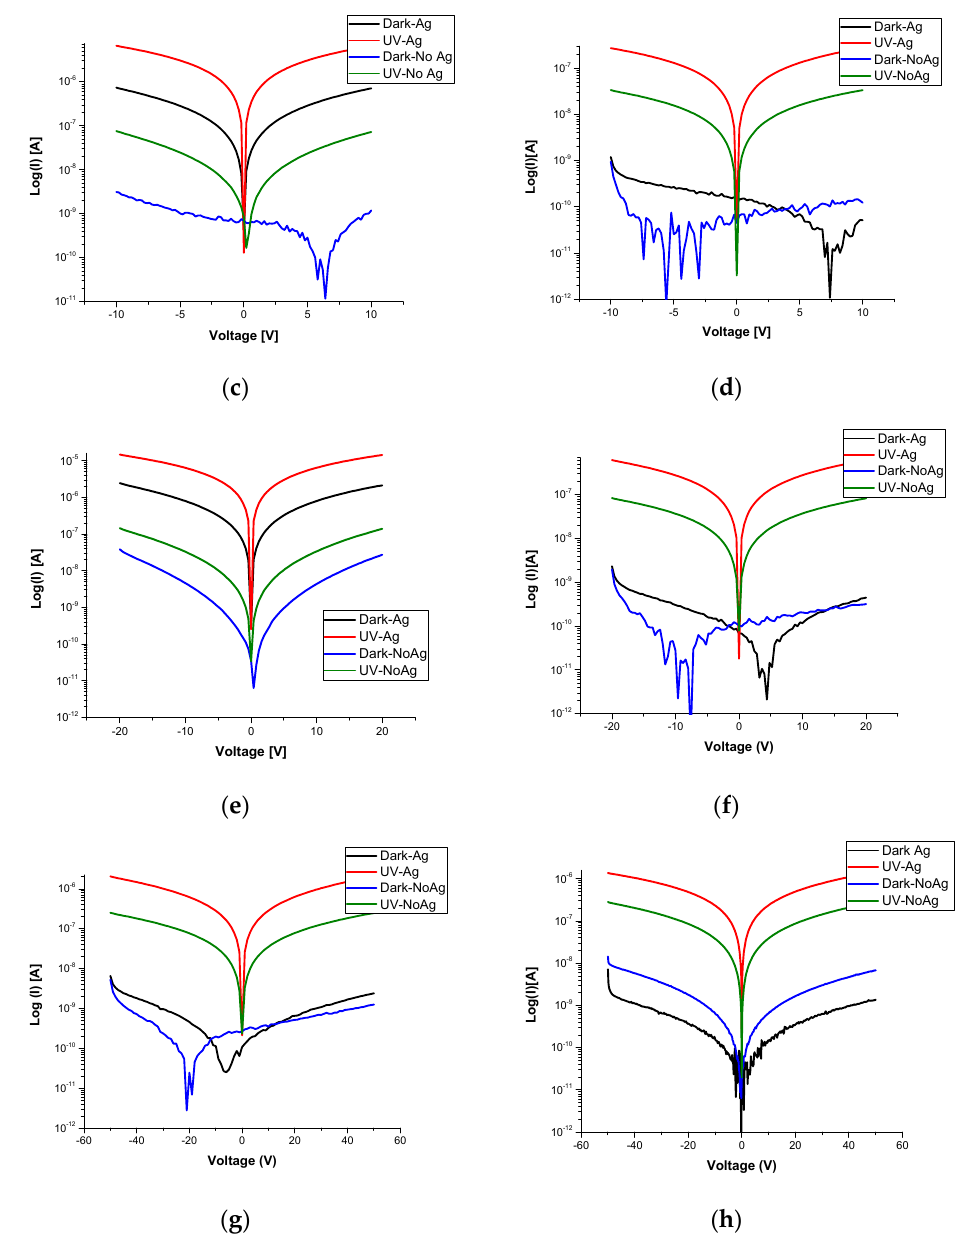
Figure 4. Semi-logarithmic plots of current density for Au/ β -Ga 2 O 3 /Au MSM without and with Ag catalyst versus applied voltage characteristics without and with UV illumination. The right column is for the distance between the probe lines <1 mm. Left column is for the distance between the probe lines <3 mm. ( a , b ) 5 V. ( c , d ) 10 V. ( e , f ) 20 V. ( g , h ) 50 V.